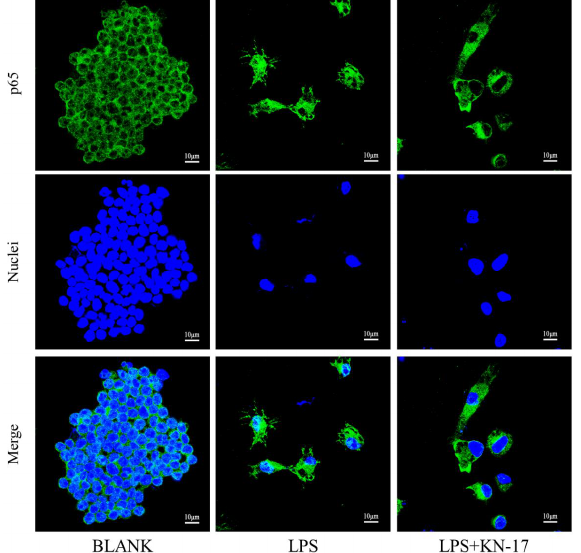
Figure 11. CLSM images of P65 in RAW 264.7 cells after different treatments. Green (P65); blue (nu- clei).